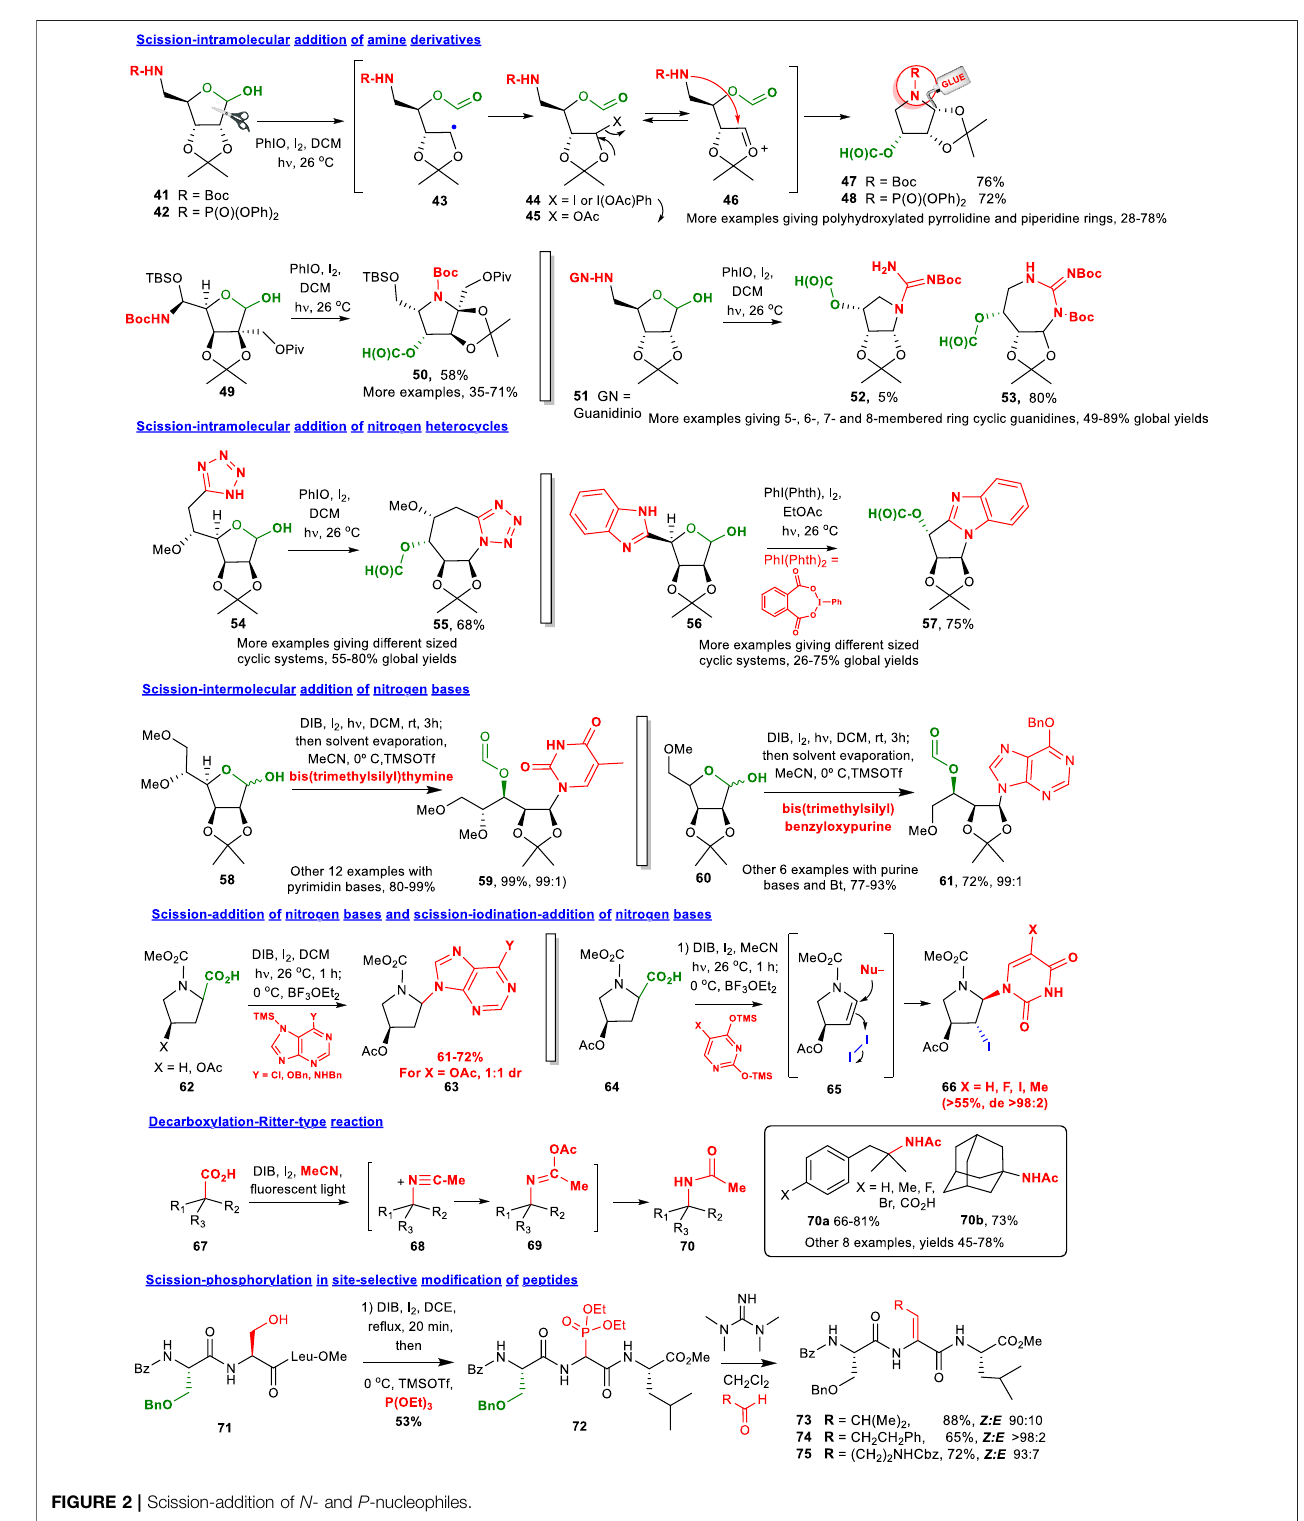
FIGURE 2 | Scission-addition of N - and P -nucleophiles.